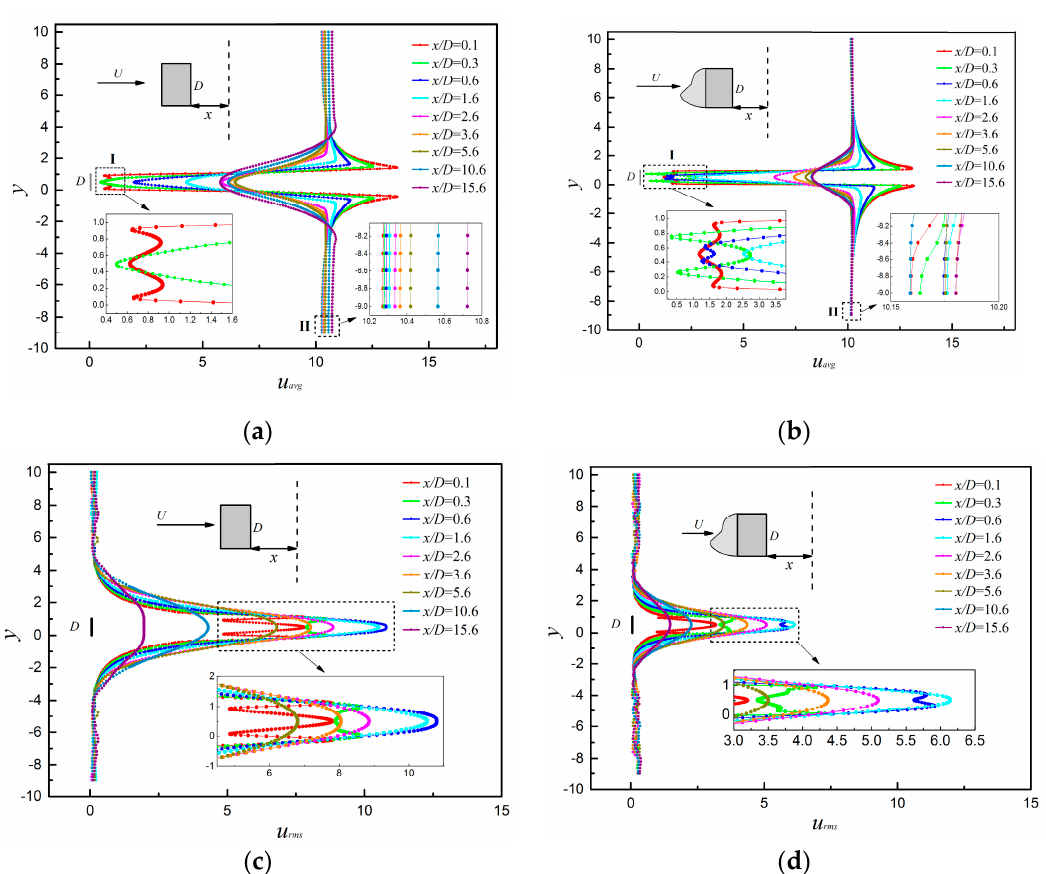
Figure 10. Velocity distributions of wake: ( a , b ): time-average velocity and ( c , d ): root-mean-square velocity. ( a ) Rectangular cylinder; ( b ) bionic attachment cylinder; ( c ) rectangular cylinder and ( d ) bionic attachment cylinder.